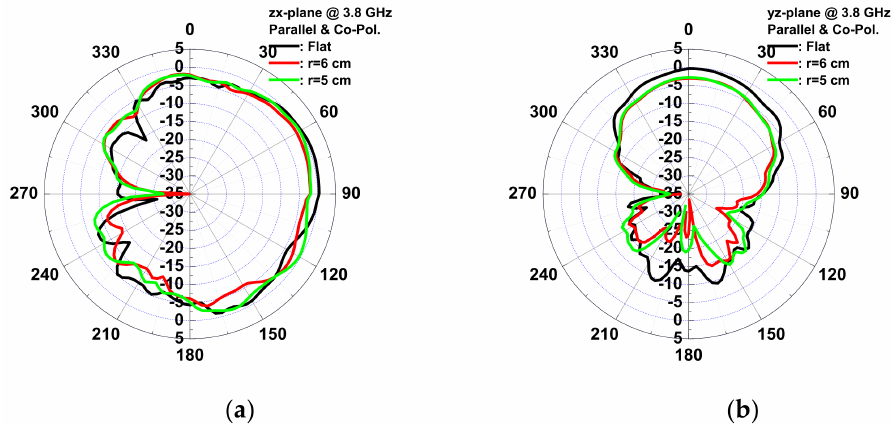
Figure 16. Measured copolarization radiation patterns of the antenna for parallel bending with dipole in ( a ) the zx-plane and ( b ) the yz-plane at 3.8 GHz.